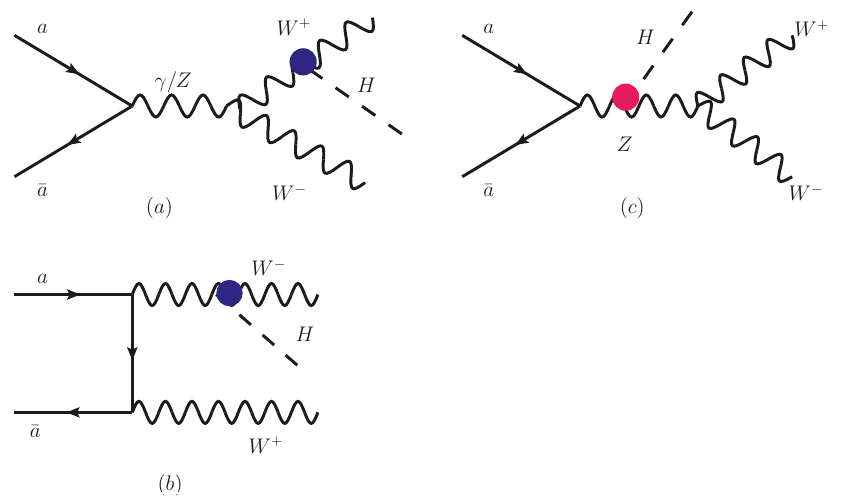
Figure 1 . The representative Feynman diagrams of a (cid:22) a state q ((cid:22) q ) or e (cid:0) ( e + ). The blue and red vertices represent the interactions of HWW and HZZ , respectively. The squared amplitude of (a) and (b) with the SM HWW coupling is denoted by 2 in eq. (2.1), and the squared amplitude of (c) with the SM HZZ coupling is denoted by jM W j 2 , while the SM interference of (a) and (b) with (c) is jM Z j diagrams with small Yukawa couplings of the Higgs boson to light